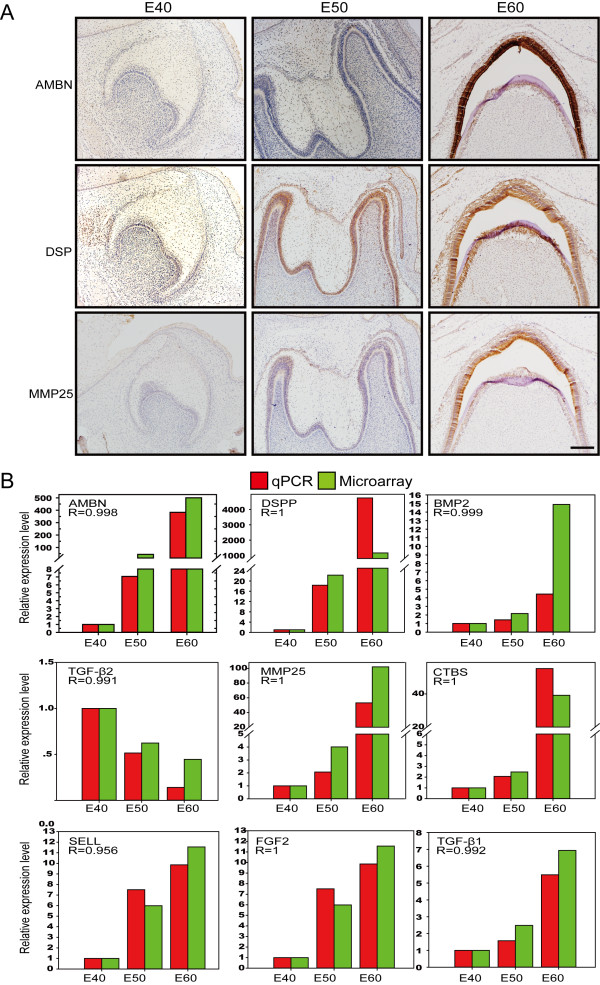
Verification of gene expression by immunocytochemistry and real-time RT-PC. (A) Immunocytochemistry assay visualized by DAB (brown) showing the expression changes of Ambn (ameloblastin), Dsp (dentin sialoprotein), and MMP25 (matrix metallopeptidase 25) were in concordance with the results of the normalized microarray. (B) Pearson correlation analysis (R > 0.9, p < 0.05) showing the expression levels of nine genes detected by real-time RT-PCR (qPCR, red box) were in agreement with the results of the normalized microarray (green box). R, Pearson correlation coefficient.